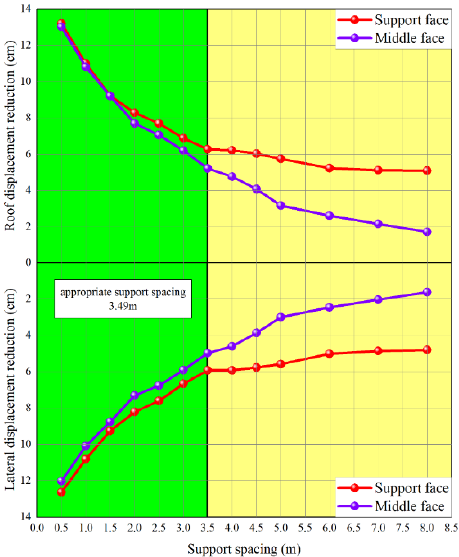
Figure 6. Displacement reduction in the support face and the middle support under the non-radial support.